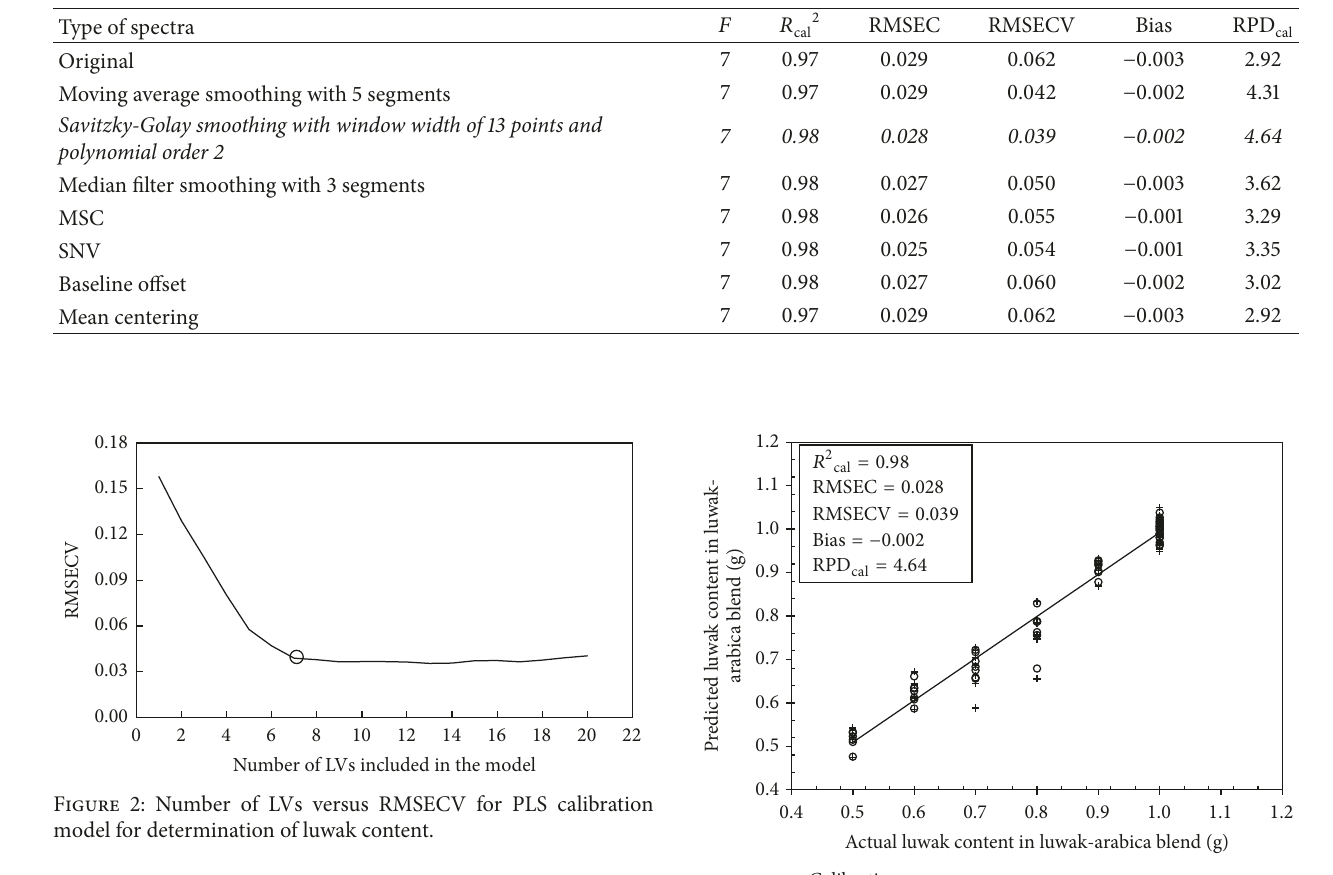
Table 2: Calibration and validation results for determination of luwak content in luwak-arabica blend using original and preprocessing spectra in the range 200–450 nm.